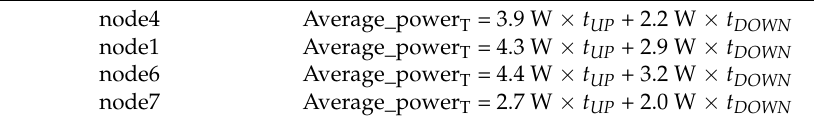
Table 9. Average-power consumed for an interval T = t UP + t DOWN .